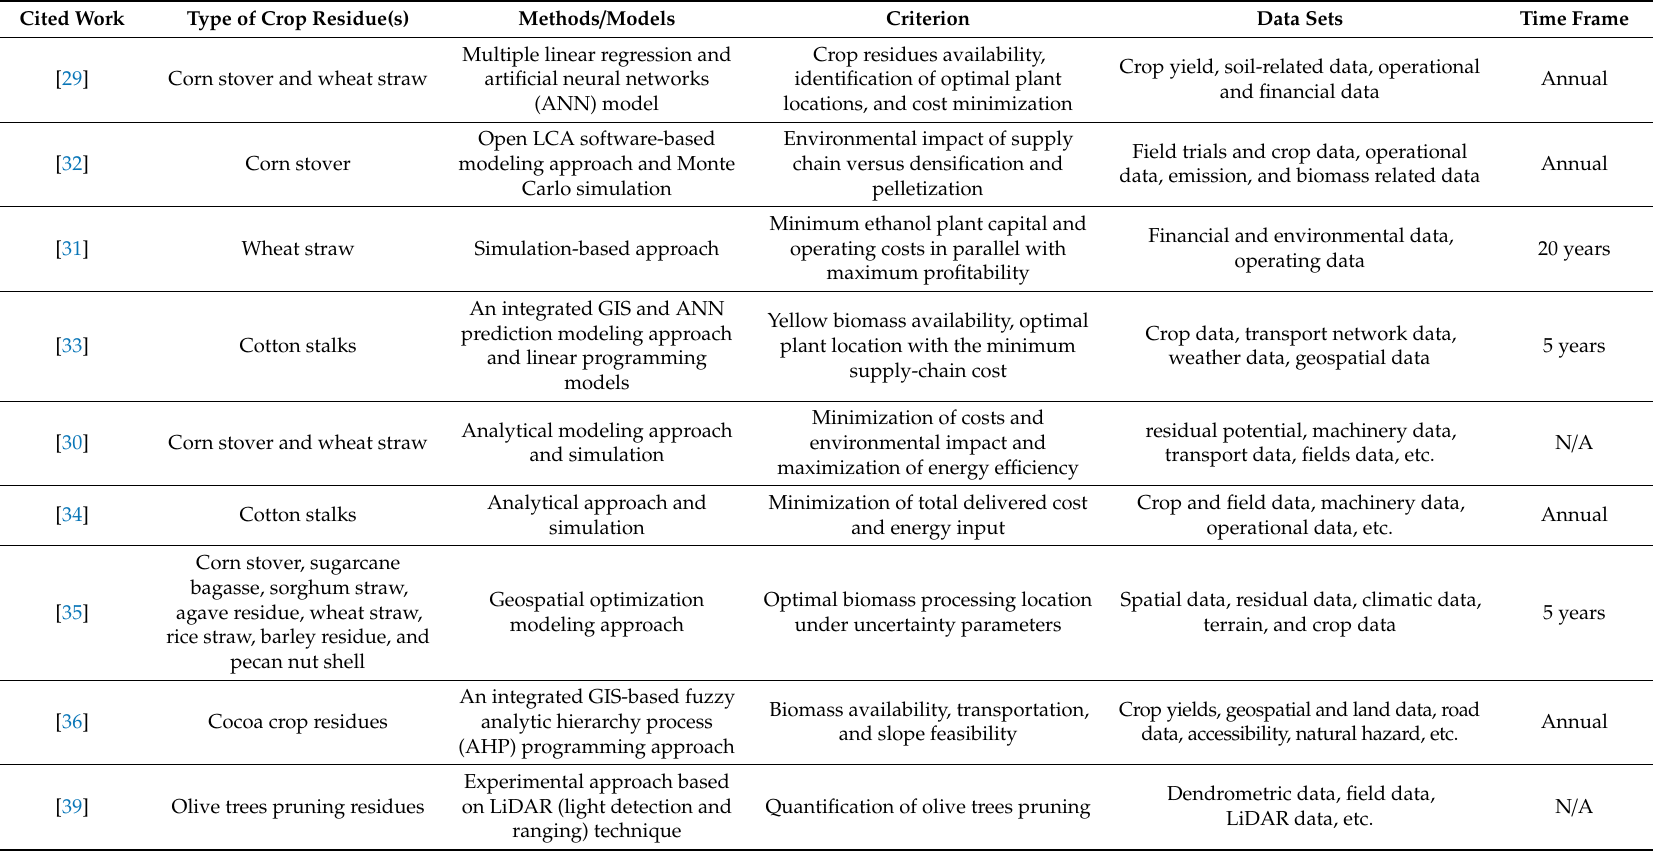
Table 2. Yellow-type biomass cited studies classified by crop residue and